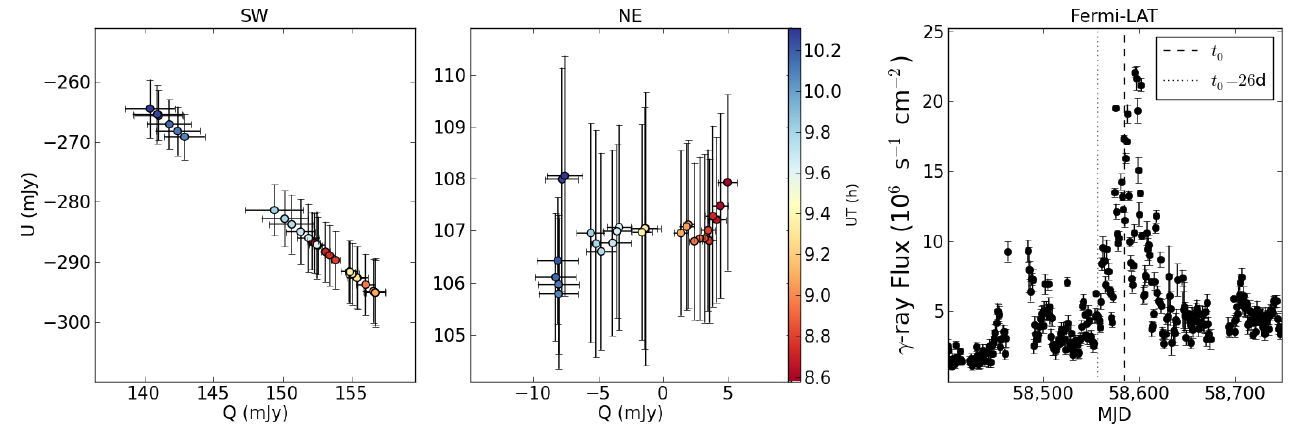
Figure 2. Left and center panels, Q vs. U plots for the SW and NE images of PKS1830 − 211, as observed by ALMA at 230GHz. Colors encode the observing time (only one epoch with a duration of 2 h). Right panel, lightcurve in γ -rays as observed by Fermi-LAT. The observing time ( t 0 , which corresponds to the NE image) is marked as a dashed line and the delayed time (i.e., t 0 − 26days, which corresponds to the SW image) is marked as dotted